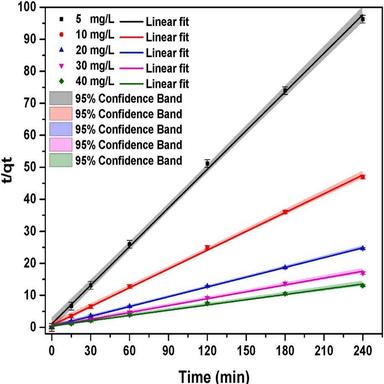
Pseudo-second order kinetic plot of N-CDs/CuFe2O4 at various initial concentrations of CR (5 mg/L, 10 mg/L, 20 mg/L, 30 mg/L and 40 mg/L). (A colour version of this figure can be viewed online.)